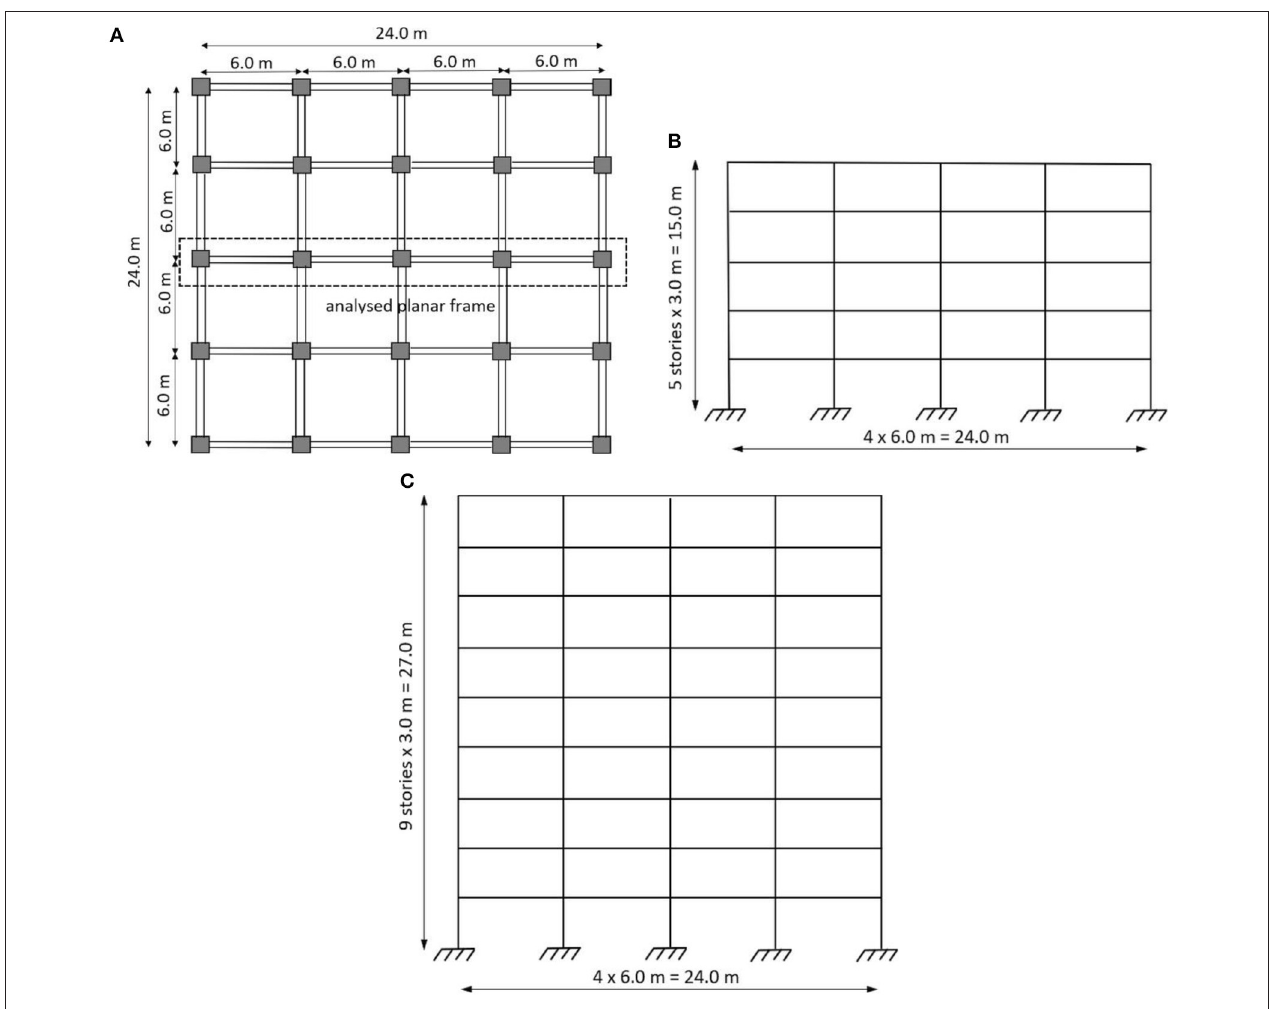
FIGURE 2 | Geomery of the analyzed structures (A) planar view; (B) elevation of the five-story structure and (C) elevation of the nine-story structure.